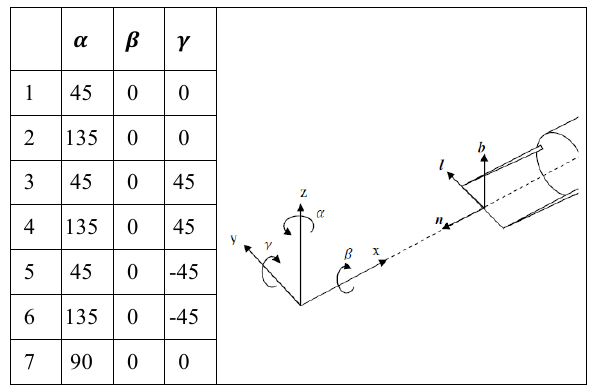
Table 1. Probe positioning angles